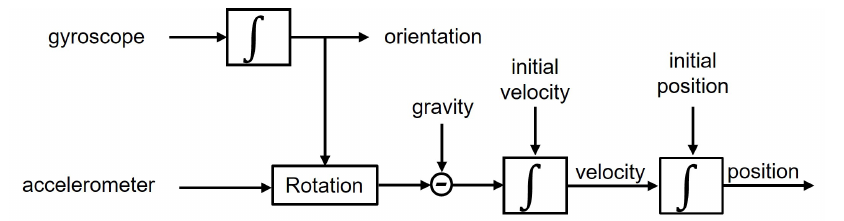
Figure 10. Strapdown Inertial Navigation System (INS), reproduced with permission from Correa, A Review of Pedestrian Indoor Positioning Systems for Mass Market Applications , published by MDPI,